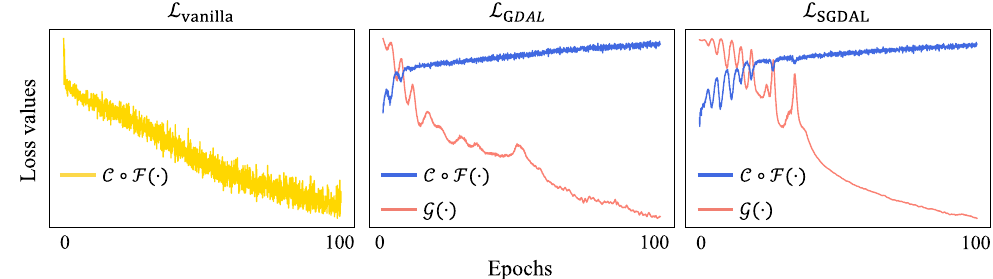
Figure 5. Loss curves of the generator network G ( · ) and the feature extraction with the classifier network C ◦ F ( · ) for the vanilla training L vanilla , the generative-discriminative adversarial learning (GDAL) L GDAL , and the semi-supervised GDAL L SGDAL